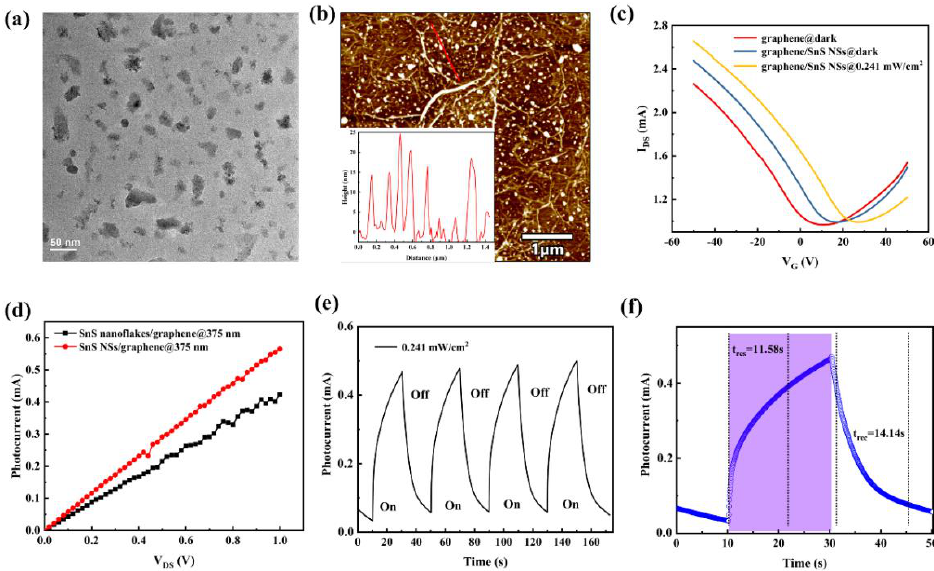
Figure 5. Morphology characterization of SnS NSs. ( a ) TEM image; ( b ) AFM image of the SnS NSs/graphene hybrids with a marked line; Inset: thickness profiles corresponding to a line in ( b ). ( c ) The transfer characteristics of the pure graphene device and SnS NSs/graphene hybrids device in the dark and light. ( d ) The photocurrent of the SnS NSs/graphene hybrids device and SnS nanoflakes/graphene hybrids device. ( e ) The time−dependent photocurrent for multiple irradiation cycles of the SnS NSs/graphene hybrids device. ( f ) The single time−dependent photocurrent in ( e ). (Wavelength: 375 nm; P = 0.241 mW/cm 2 ).